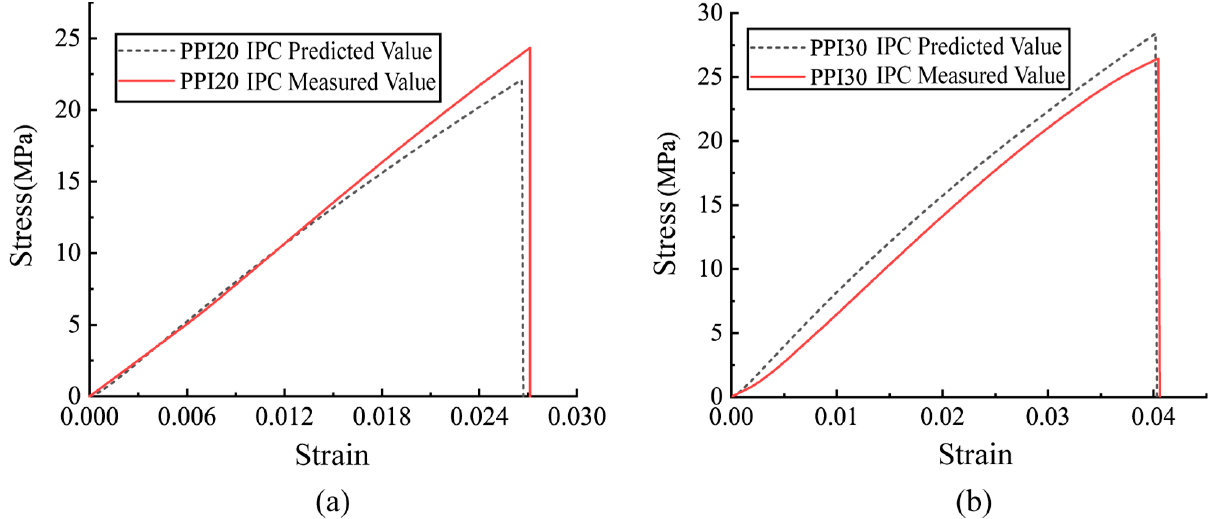
Figure 14. Comparison of predicted and measured results of intrinsic structure curves for Ni-Fe/EP IPC ( a ) PPI20 and ( b ) PPI30.